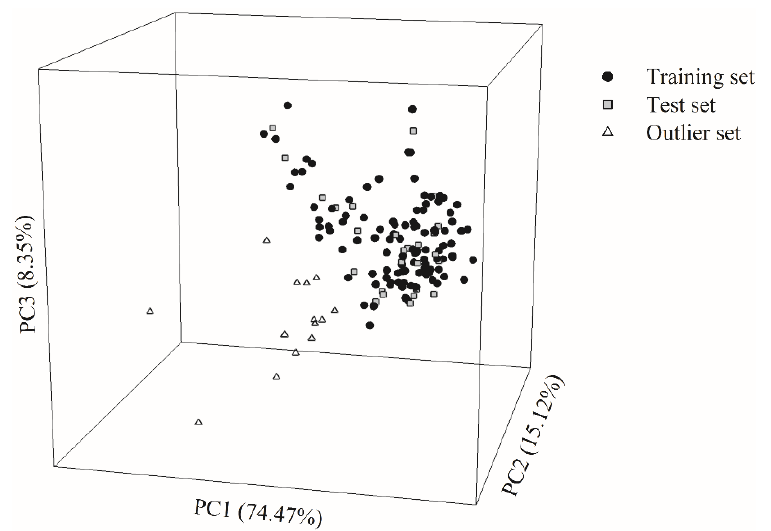
Figure 1. The chemical space spanned by three principle components (PCs) displays the distribu- tion of the data samples in the training set (solid circle), test set (gray square), and outlier set (open triangle).